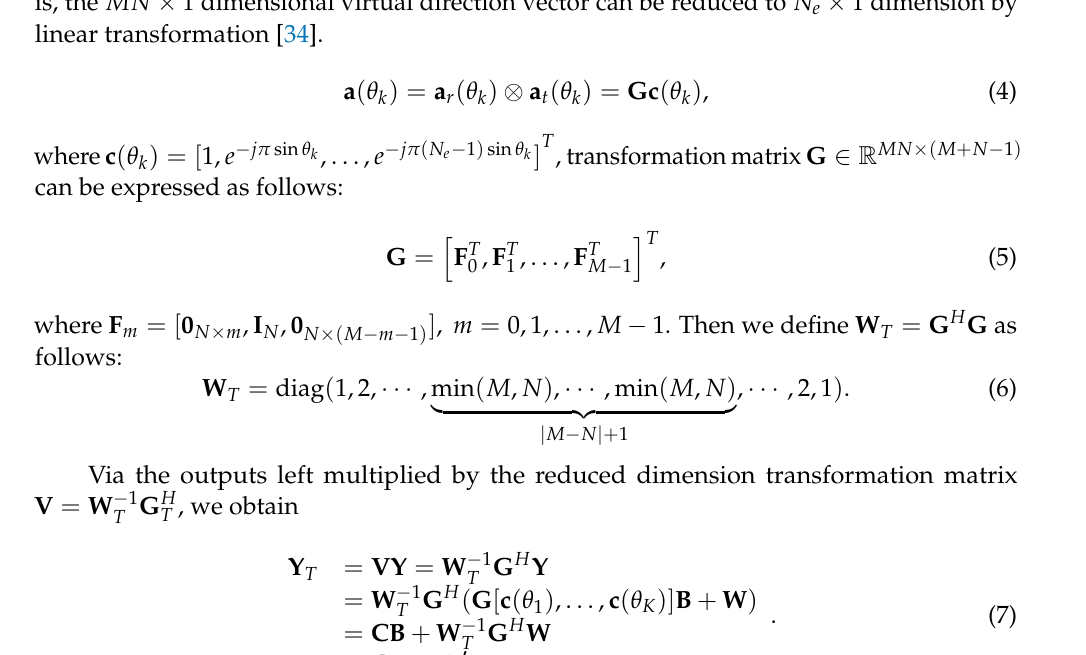
represents the receive direction matrix with represents the transmit direction matrix with the